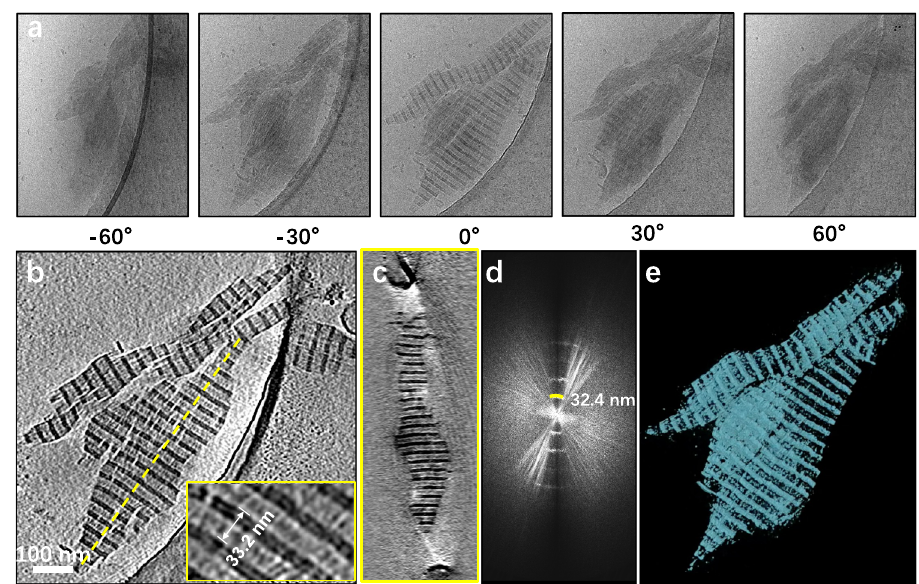
Fig. 2 | Cryo-electron tomography of P10BP10 collagen fi brils. a Tilt series of collagen fi bers at tilt angles ranging from − 60° to +60°. b Slice views of the tomogram of P 10 BP 10 collagen fi bers with characteristic banding patterns. Inset in b shows a zoomed-in view with measurement of periodicity. c Cross-section of a